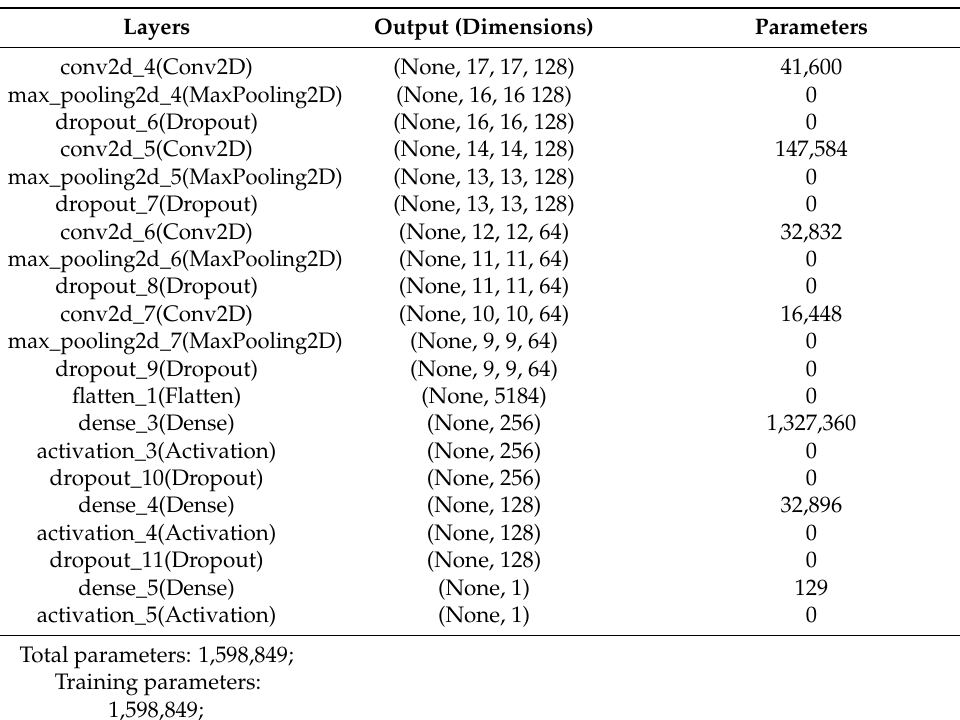
Figure 5. Structure of the CNN model in our research. Table 1. The detailed information of the layers and parameters in our